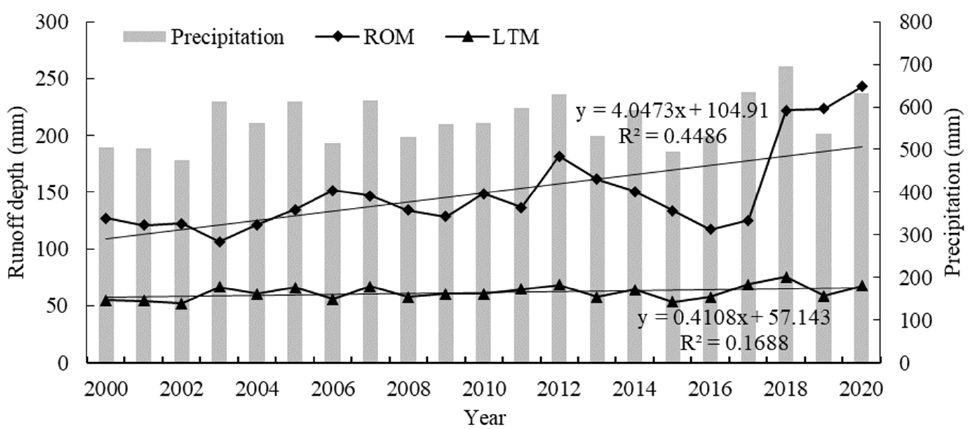
Figure 5. Interannual variation in runoff depth and precipitation.